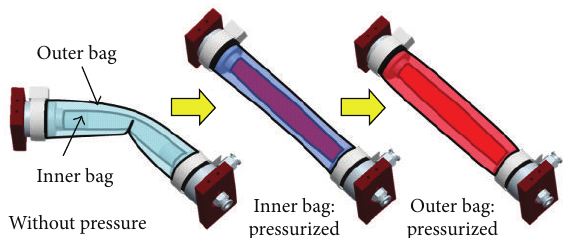
Figure 3: Schematic of dual structural actuator.